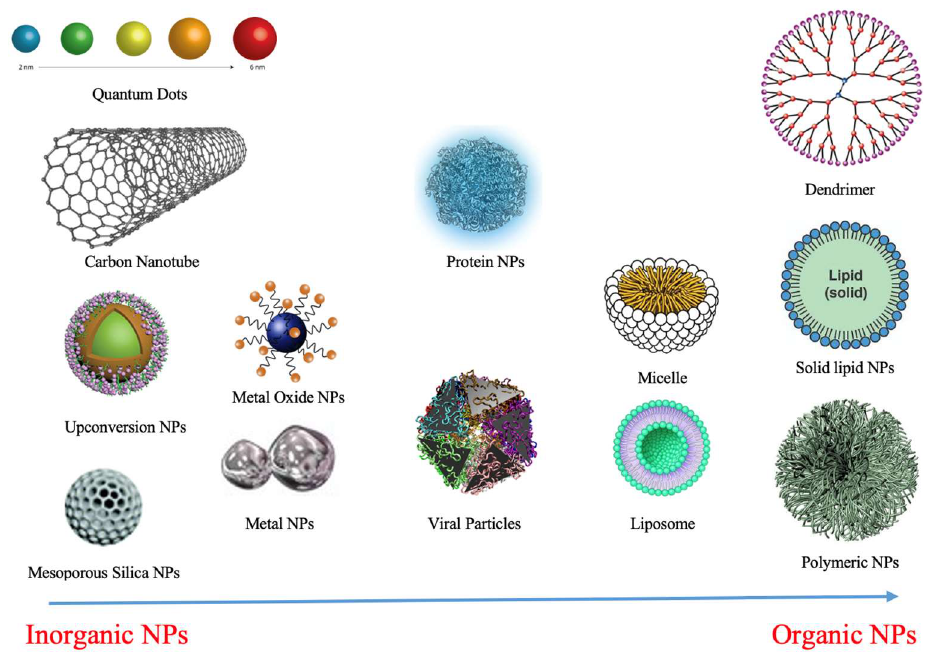
Figure 2. Classification of nanoparticles.